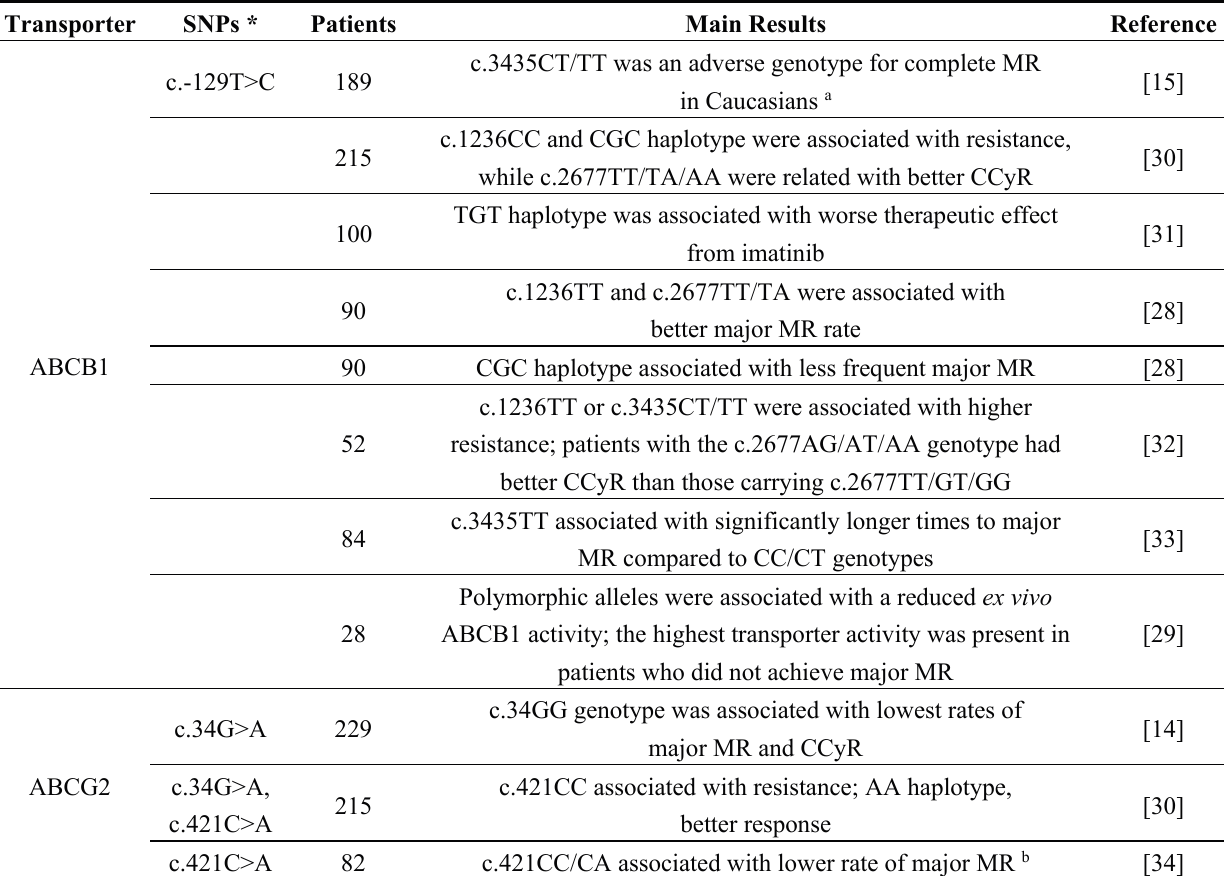
Table 1. Clinical trials investigating the role of ABCB1 and ABCG2 on the imatinib efficacy. In the case of ABCB1, all of the listed studies evaluated the c.1236C>T, c.2677G>T/A, c.3435C>T polymorphisms. Other SNPs (single nucleotide polymorphisms) are